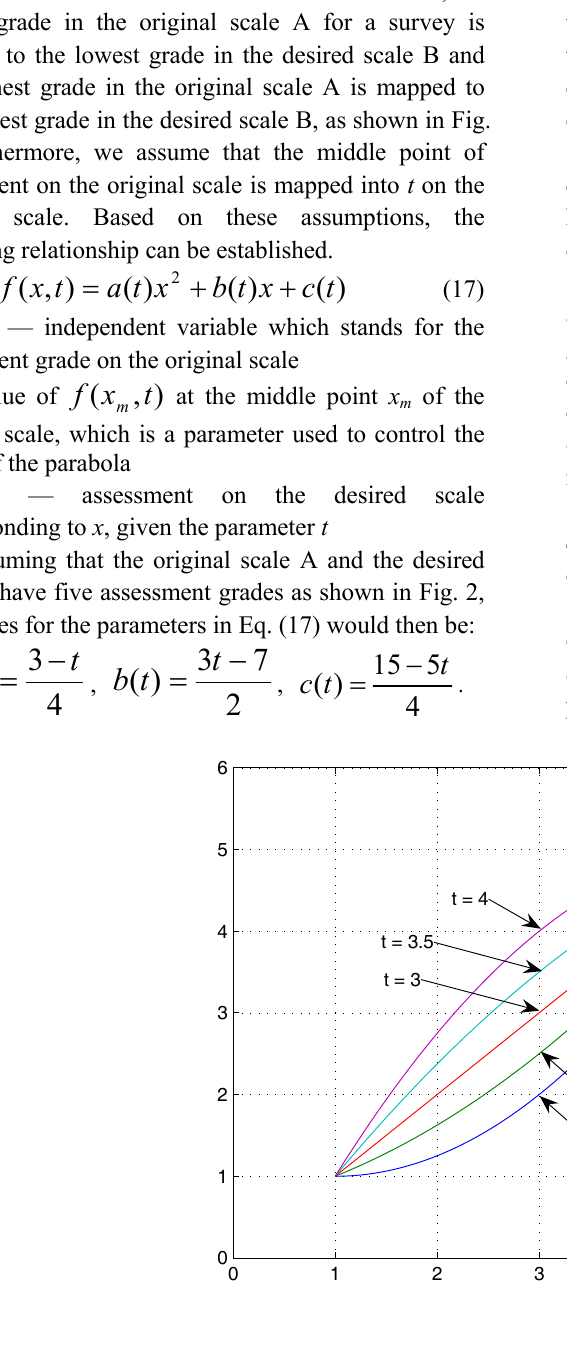
Fig. 3. Parabolas of the quadratic function with different value for parameter